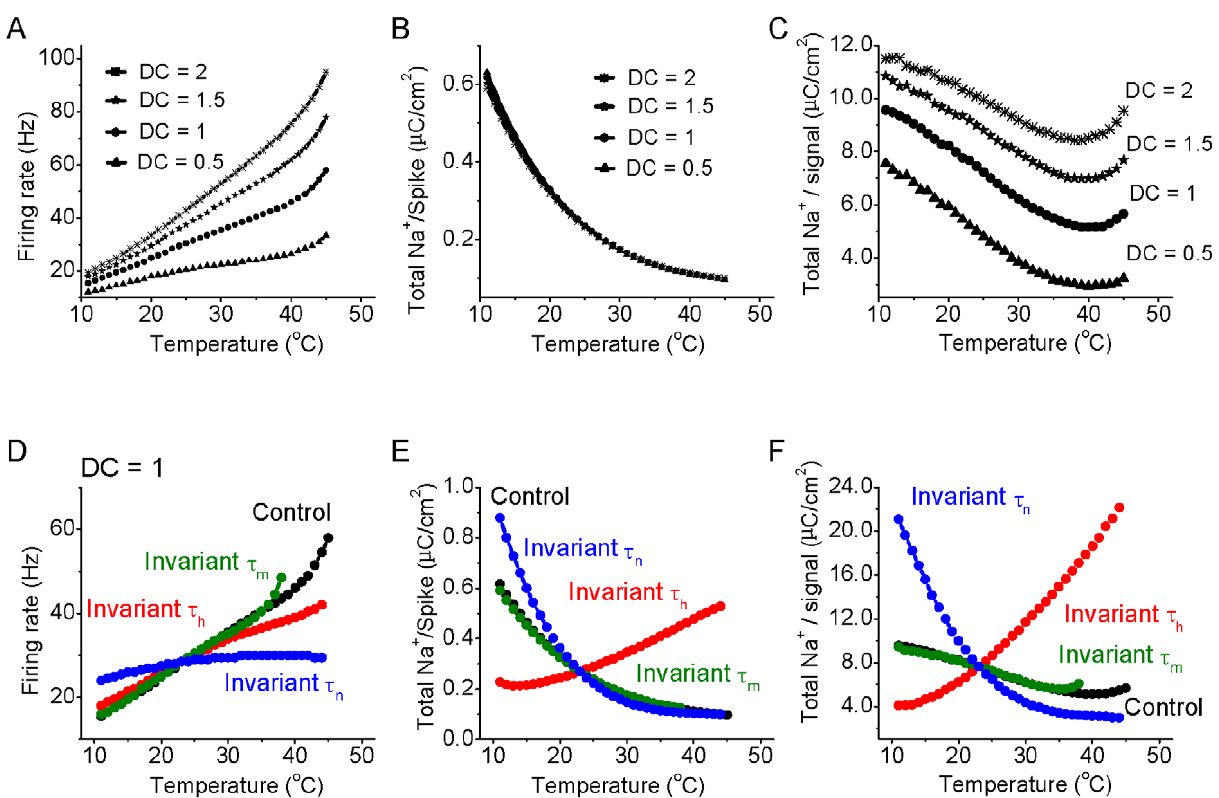
Figure 6. Effect of temperature on firing rate and total energy usage for the cortical model neuron in response to different intensities of DC input. A. The firing rate of the model neuron increases as a function of temperature for DC=0.5, 1, 1.5 and 2 6 10 2 2 pA/ m m 2 (500 ms duration) respectively. B. The total sodium charge entering during one action potential decreases exponentially as a function of temperature for DC=0.5, 1, 1.5 and 2 6 10 2 2 pA/ m m 2 , respectively. C. For the conditions in the above four DC inputs, the total sodium charge (sodium charge per spike times the firing rate) for a given DC signal as a function of temperature. Note that the total Na + entry reaches a minimum at a temperature of between 37–42 u C. D. The firing rate increases as a function of temperature for the normal situation (black), and when t m (green), t h (red) and t n (blue) are kept invariant. Notice that the I K activation time constant t n is the key factor controlling the firing rate change as a function of temperature. E. For the above four situations, the total Na + charge per single spike as a function of temperature. Notice that I Na inactivation time constant t h is the key factor controlling the total Na + charge per spike as a function of temperature. F. For the above four situations, the total Na + charge per DC input (nC/ cm 2 ) as a function of temperature. Note that the total Na + entry does not go through a global minimum for both test groups with temperature- independent t h and t n .